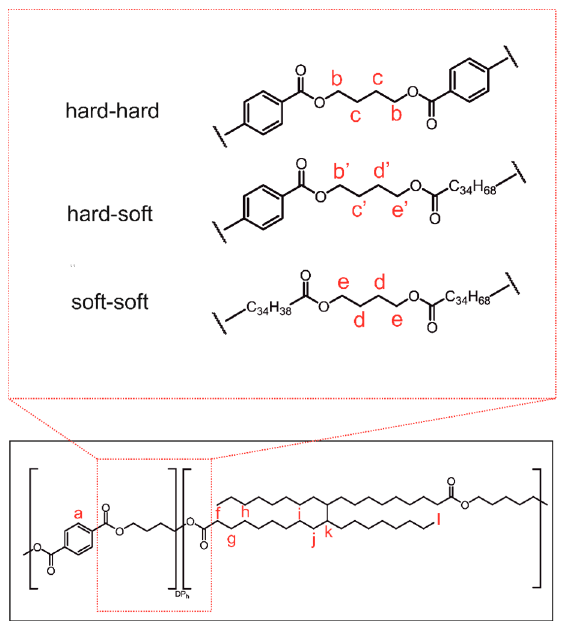
Figure 1. Chemical structure of poly(butylene terephthalate- r -butylene dilinoleate) (PBT–DLA) copolymer. The inset ( top ) presents the possible arrangements and combinations of adjacent segments, hard: butylene terephthalate, soft: butylene dilinoleate. Characteristic protons discussed in the text are marked in red. DP h —theoretical degree of polycondensation of hard segments = 1.21.